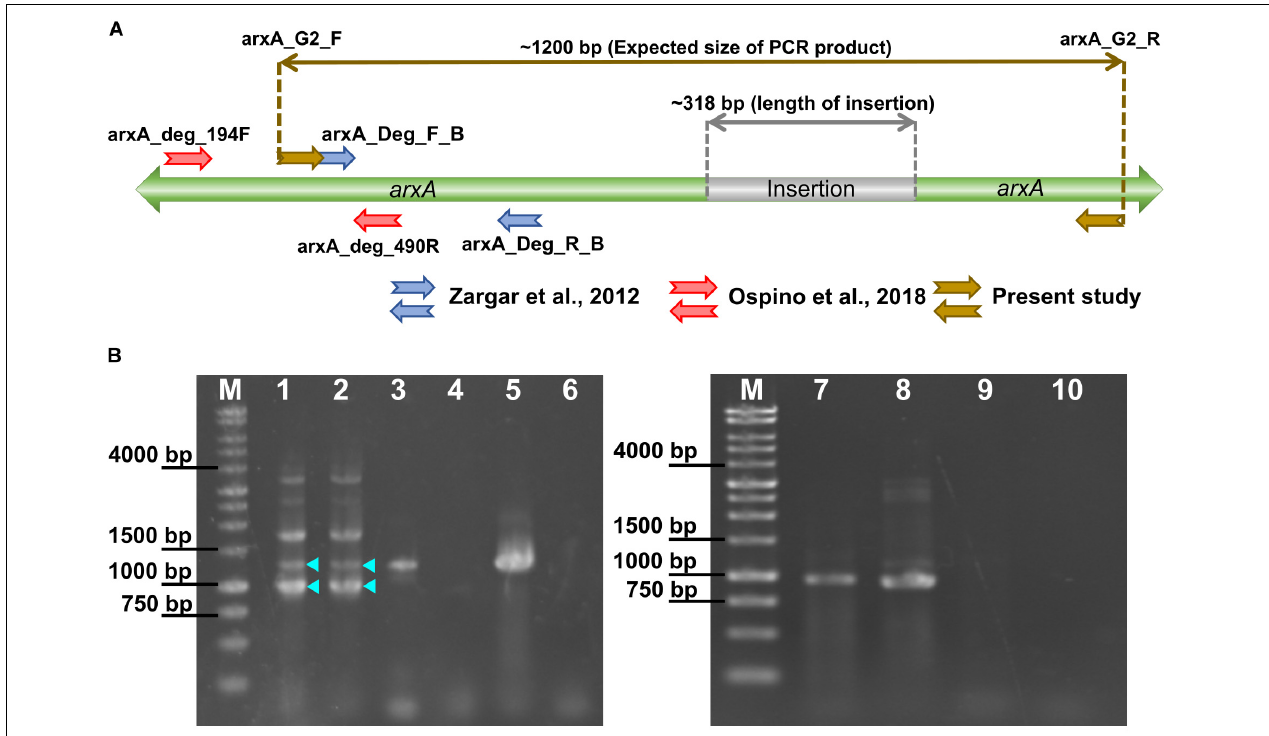
FIGURE 8 | (A) Positions of PCR primers for the arxA gene and expected size of the PCR product. (B) Gel images showing the results of PCR with newly designed primers. Samples in lanes are: M, 10 kb DNA ladder as a size marker; (1–2) Jozankei microbial mat; (3) Sulfuritortus calidifontis J1A; (4) Nitrincola lacisaponensis 4CA; (5) Sulfuricella denitrificans skB26; (6) no template control; (7) Mizugaki water; (8) Alkalilimnicola ehrlichii MLHE-1; (9) Sulfuritalea hydrogenivorans sk43H; (10) no template control. In lanes 1 and 2, bands of expected sizes are marked with